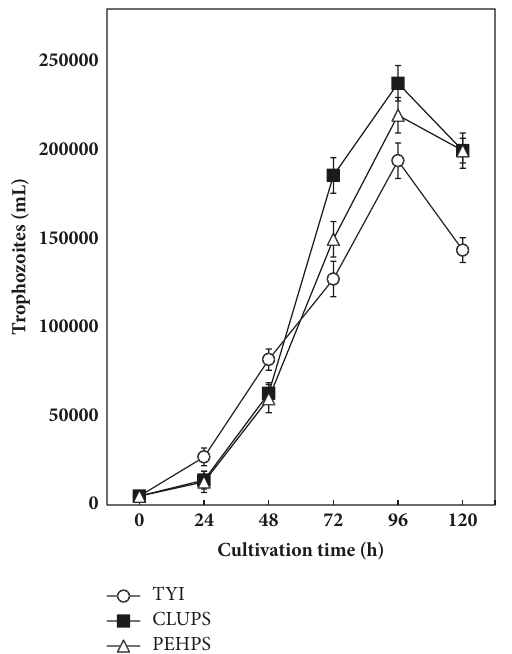
Figure 1: Comparative 5-day growth of E. histolytica trophozoites in PEHPS, TYI-S-33, and CLUPS. Results are represented as mean ± SD of quintuplicated assays.